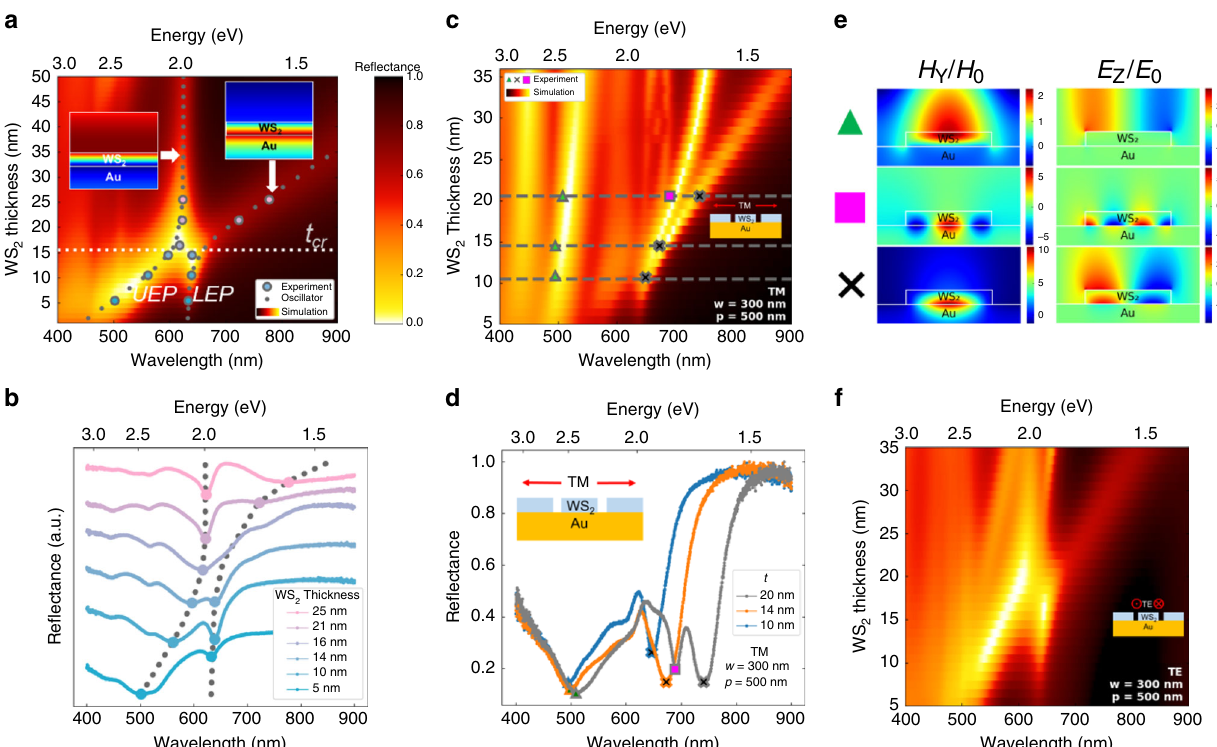
Fig. 3 Below-gap resonant absorption in WS 2 on Au. a Plot of simulated re fl ectance spectra of unpatterned WS 2 on Au with varying WS 2 thickness on the y axis. The primary exciton mode of WS 2 can be seen at ~2.0 eV which couples with the cavity mode, splitting the exciton into the upper exciton-polariton (UEP) and the lower exciton-polariton (LEP). A low Q Fabry – Perot-like cavity is formed even in deep-subwavelength thickness regime as a result of the thin- fi lm interference. Insets show the H Y fi eld pro fi les corresponding to the exciton mode (left) and the cavity mode (right). Re fl ectance color scale is the same for ( a , c , f ). Dashed lines represent a model of two coupled oscillators, while circles represent experimentally measured peak positions shown in ( b ). b Experimental unpolarized re fl ectance spectra of unpatterned WS 2 on Au with varying thickness. The experimentally measured thicknesses are 5, 10, 14, 16, 21, and 25 nm. The UEP and LEP peaks are emphasized with circles and are superimposed on panel a to show strong matching with simulation. c Simulated re fl ectance spectra under TM polarization of a 1D WS 2 grating on an Au substrate with varying thickness. The structure has a fi xed width and period of 300 nm and 500 nm, respectively. The non-dispersive mode induced by dielectric grating emerges as the highest-energy resonance (~500 nm) while plasmon resonances of varying orders emerge at lower energies. For higher thickness regimes, an additional plasmon resonance emerges which red- shifts with increasing thickness. d Experimental TM re fl ectance spectra of the 1D WS 2 grating on the Au substrate with w = 300 nm and p = 500 nm. The peaks corresponding to various modes are coded with matching symbols on ( c ). e E Z and H Y mode pro fi les for the various modes matching with the corresponding symbols in ( c , d ). f Simulated re fl ectance spectra under TE polarization of a 1D WS 2 grating on an Au substrate as thickness is